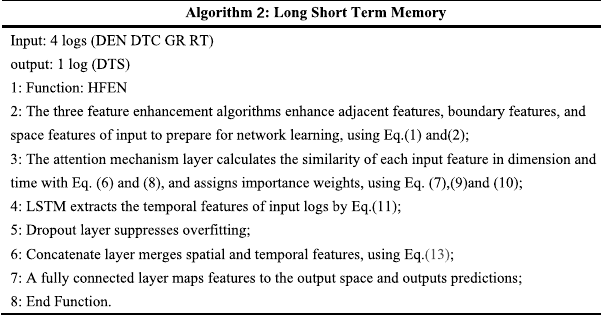
Algorithm 2: Long Short-Term Memory